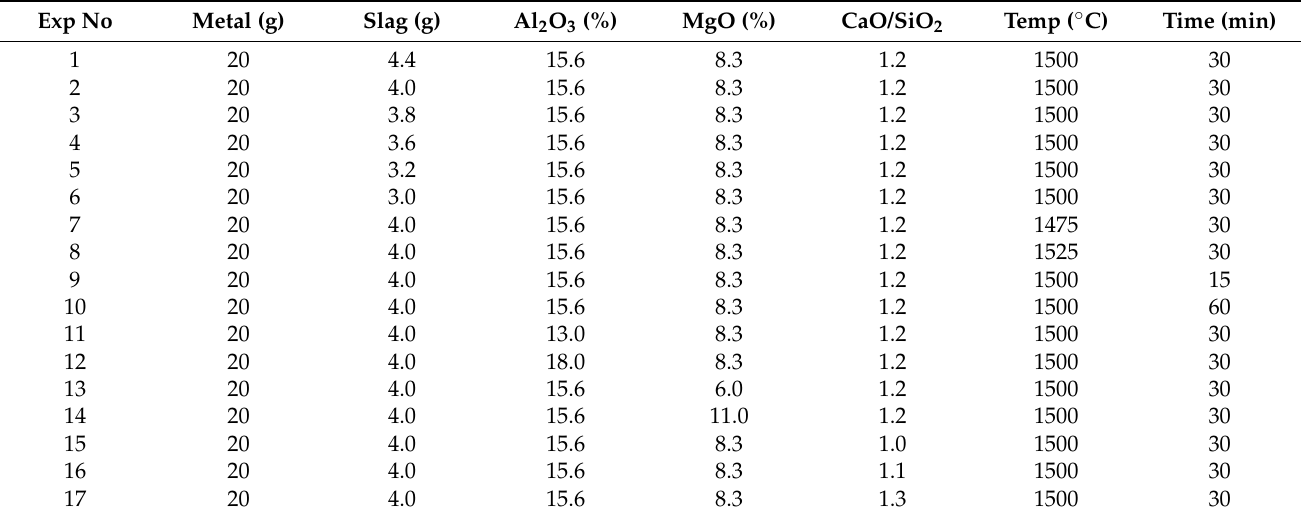
Table 1. Experimental conditions for slag-metal reaction experiments.